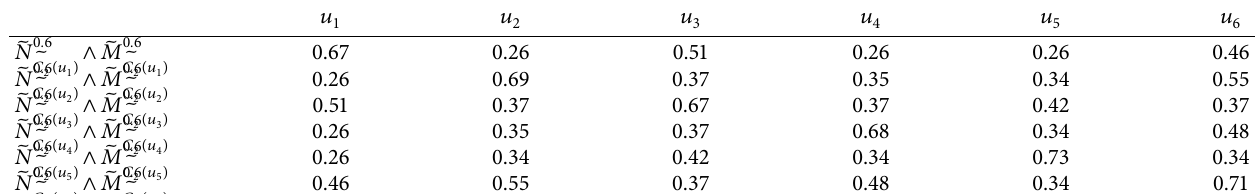
∧ 􏽥 M 0 . 6 􏽥 C 2 ( u i ) C 2 ( u i